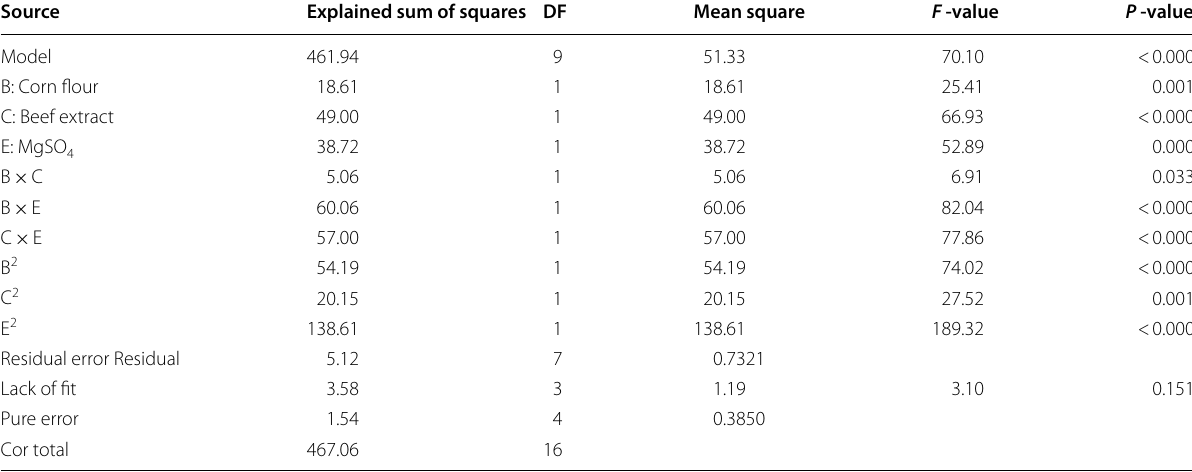
Table 5 Analysis of variance and lack‑of‑fit tests for the response surface models Source Explained sum of squares